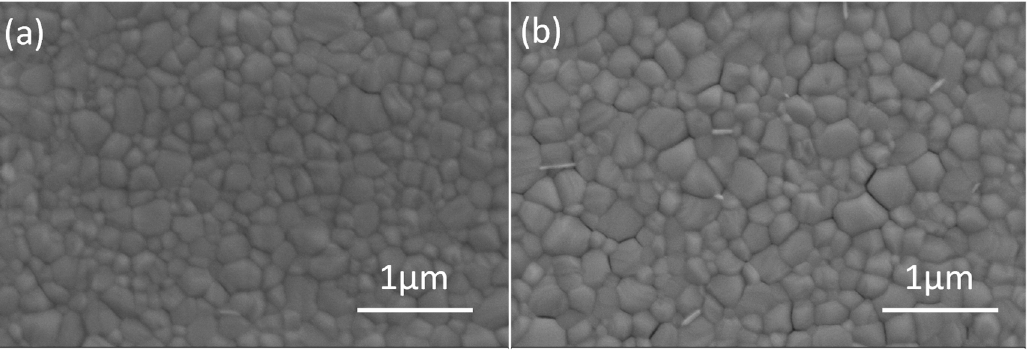
Figure 4. SEM images of ( a ) pristine and ( b ) DMSO solvent washing treated PEDOT:PSS based perovskite films.